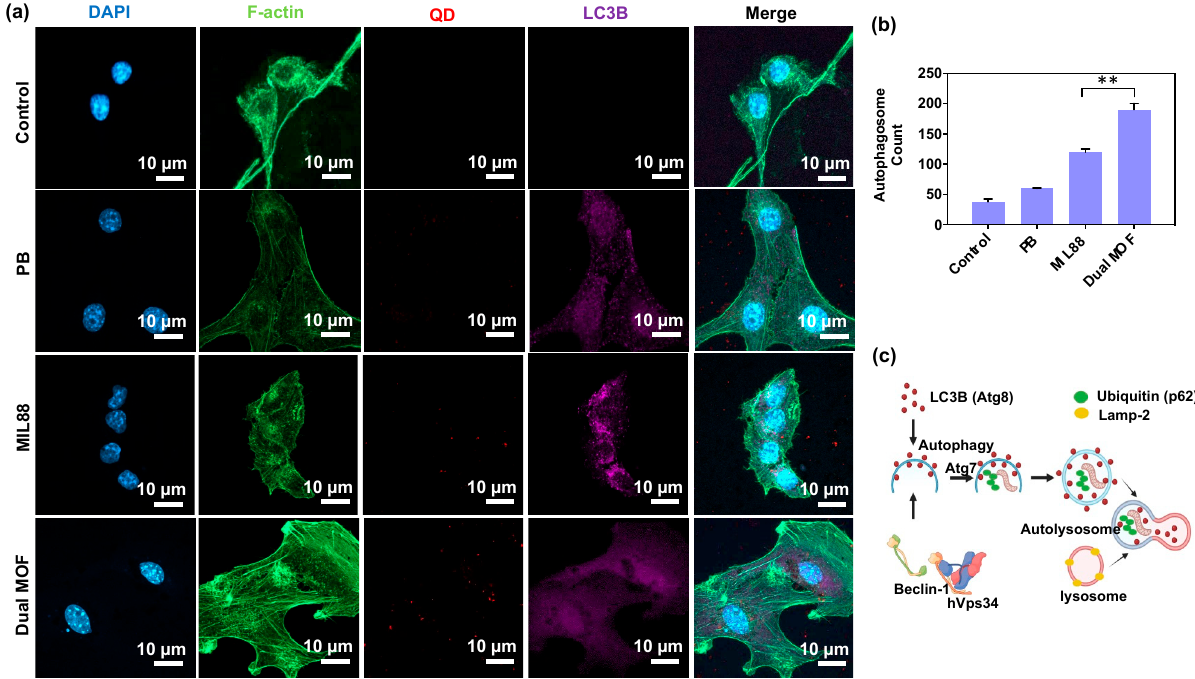
Figure 4. Autophagy activation through LC3B protein expression. ( a ) Confocal fluorescence images of B16F10 cells incu- bated with PB, MIL88, and MIL88@PB (100 µg/mL) (blue, green, and red fluorescence represent nucleus, cytoskeleton, and NP staining with DAPI, F-actin, and QD, respectively; purple fluorescence represents LC3B expression, which shows the quantity of autophagosomes), the experiment was conducted three times on three independent 6-well plates. ( b ) Autoph- agosome quantification of PB, MIL88, and MIL88@PB by image J analysis software. ( c ) Schematic representation showing increased LC3B expression leads to increased autophagy expression.